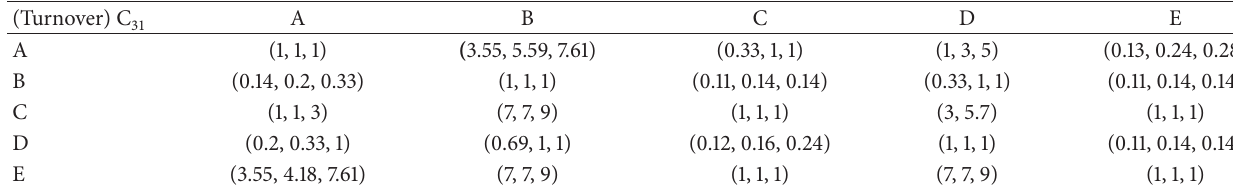
Table 9: Options concerning turnover subcriteria.